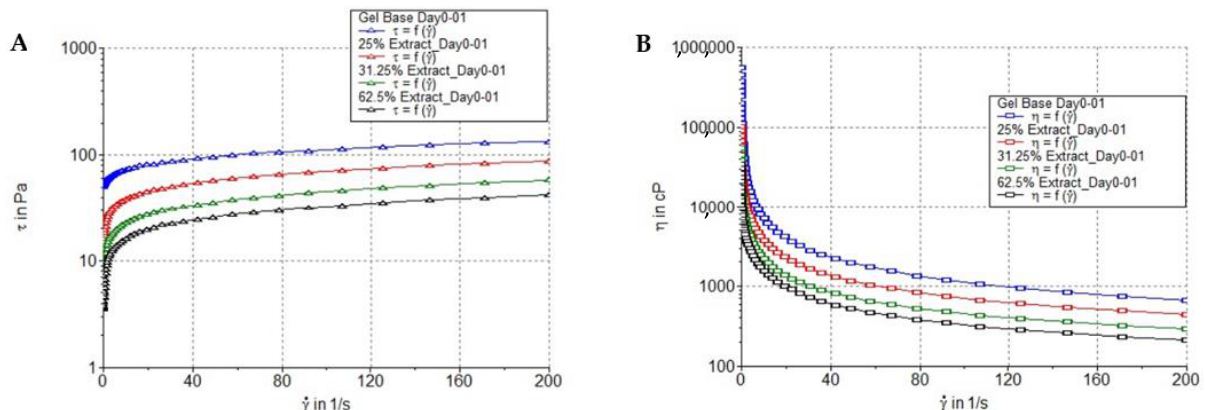
Figure 8. Rheology measurement. ( A ) Flow curves of gel base, gel containing 25, 31.25, and 62.5% w/w extract expressed as shear rate and applied shear stress. ( B ) Flow curves of gel base, gel containing 25, 31.25, and 62.5 % w/w extract expressed as viscosity and shear rate.